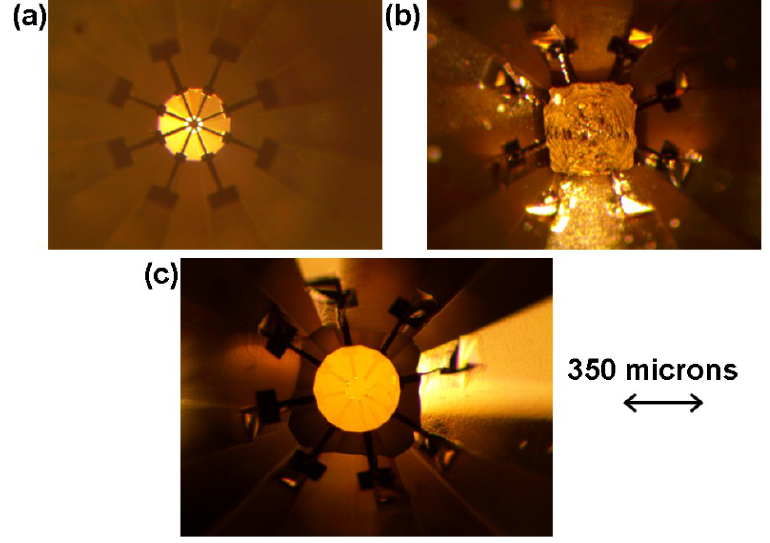
Figure 2. ( a ) Eight electrical probes lithographed onto diamond anvil; ( b ) CVD diamond grown on top of eight probe pattern; ( c ) A fully fabricated designer diamond anvil with a culet size of 370 microns with a probe circle diameter of 85